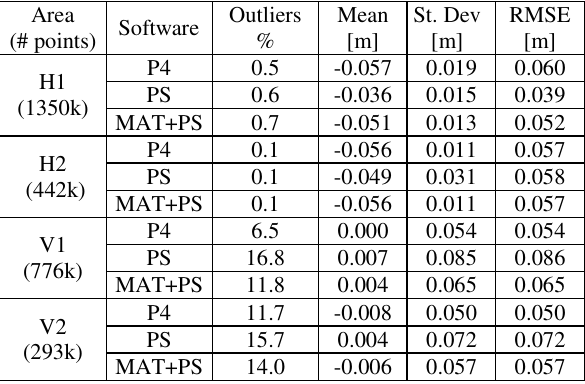
Table 4. Statistics of the differences between the dense clouds and the reference laser scan, for the four different analysed